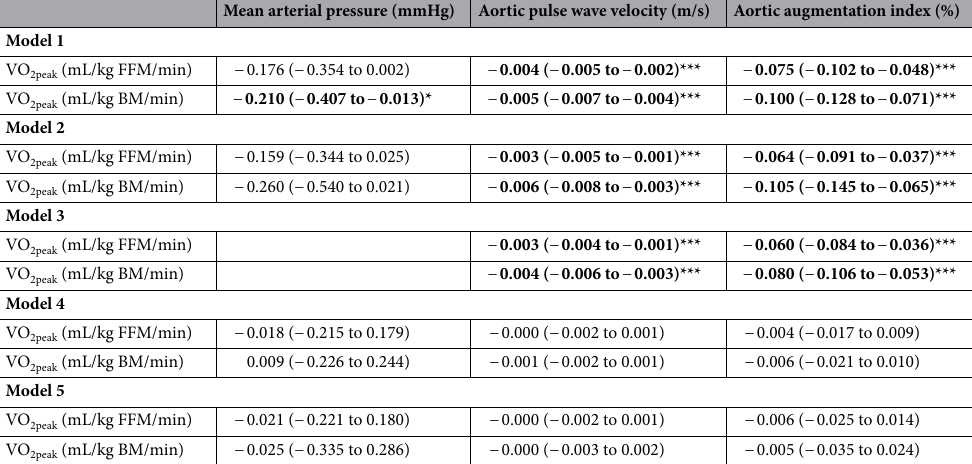
Table 2. Associations of cardiorespiratory fitness with mean arterial pressure and arterial stiffness in women. The data are β coefficients and their 95% confidence intervals. Model 1: adjusted for testing method (cycle ergometer vs. treadmill), Model 2: the data were adjusted for model 1 + body fat percentage, Model 3: the data were adjusted for model 1 + mean arterial pressure, Model 4: the data were adjusted for model 1 + age; Model 5: the data were adjusted for testing method (cycle ergometer vs. treadmill), body fat percentage, fat-free mass index, mean arterial pressure, and age. Aortic pulse wave velocity was logarithmically transformed, and square root transformation was applied to Aortic augmentation index. *p < 0.05, **p < 0.01, ***p < 0.001. Significant associations are in